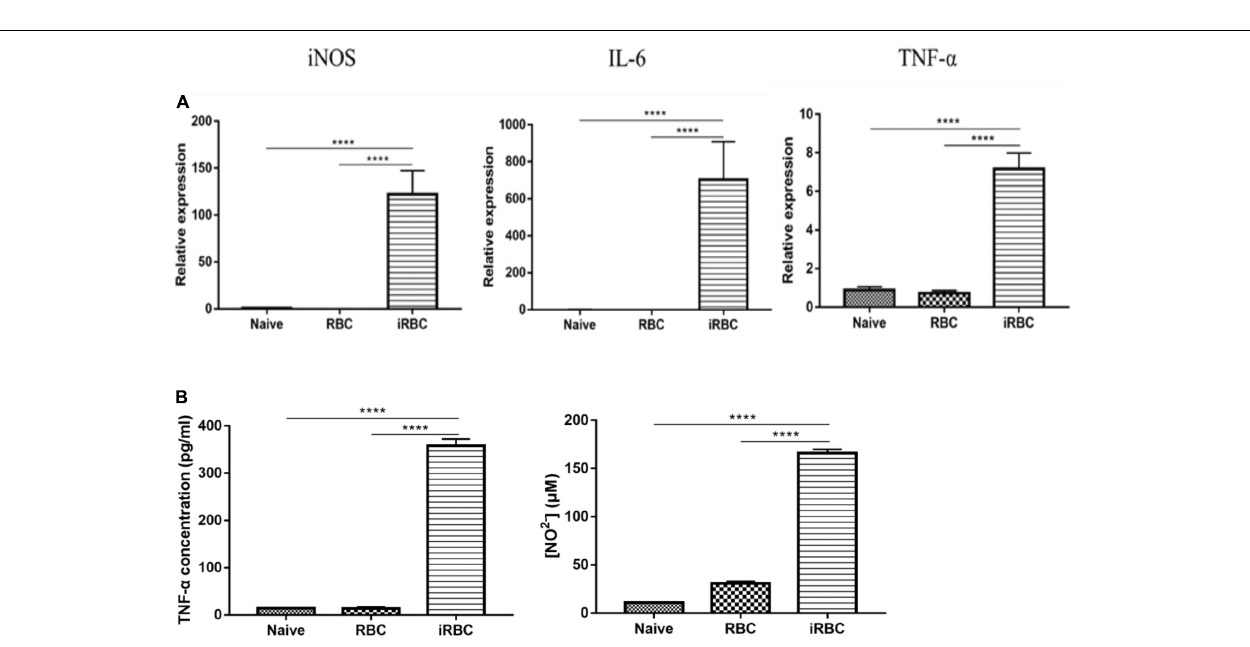
FIGURE 7 | Effects of B. microti culture supernatant on macrophage polarization. (A) qPCR analysis of the effects of B. microti culture supernatant on the expression levels of iNOS, IL-6, and TNF- α in RAW264.7 macrophage cells; the serum-free culture supernatant of B. microti was collected and incubated with RAW264.7 cells for 24 h. (B) Concentration of TNF- α and NO 2 − in RAW264.7 cell culture supernatant as detected by using the ELISA kit and Griess reagent, respectively. Error bars are SD; **** p ≤ 0.0001.